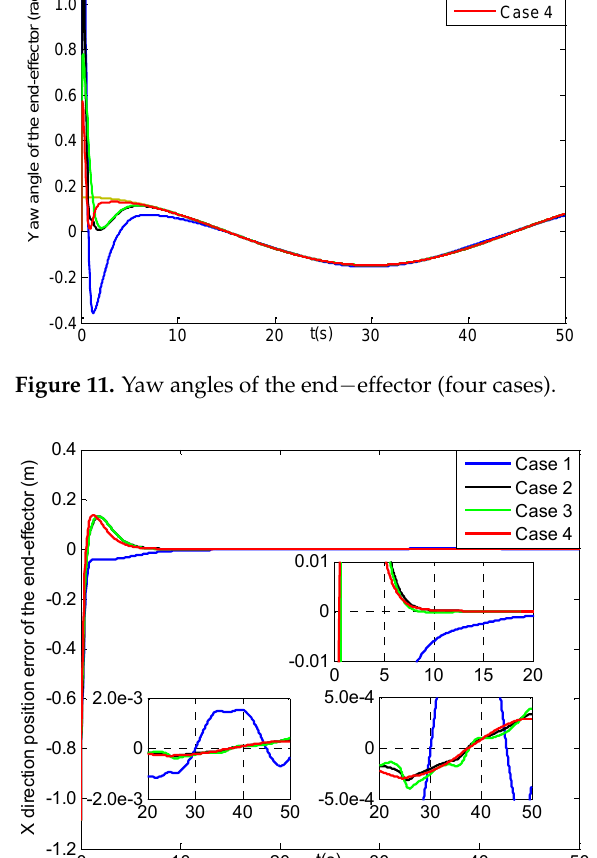
Figure 13. Y direction position errors of the end − effector (four cases).